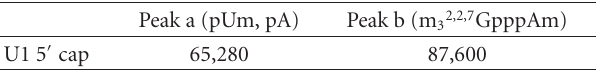
Table 10: The [ 32 P]cpm radioactivity distribution in nucleotides and cap core produced by RNase P1 digestion of U1 5 (cid:2) oligonu- cleotide [16]. The [ 32 P]-labeled U1 5 (cid:2) oligonucleotide obtained by digestion of U1 RNA with RNase T2, RNase U2, and alkaline phos- phatase was treated with P 1 nuclease which cleaves all phosphodi- ester bonds but not pyrophosphate bonds. The products were sep- arated on a DEAE column (Figure 23). The radioactivity in peak a (mononucleotides pUm, pA) and peak b (cap core m 32,2,7 GpppAm) were determined by Packard liquid scintillation